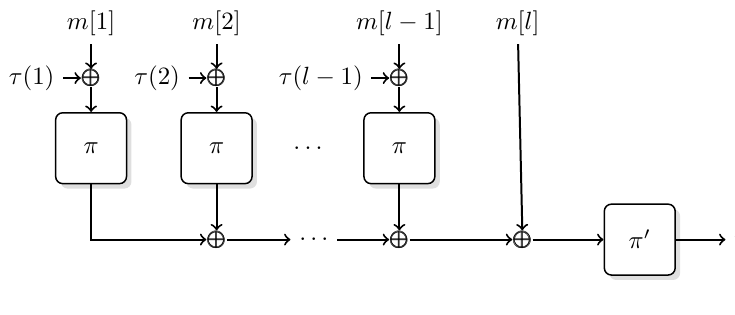
Figure 3.1: The simplified PMAC